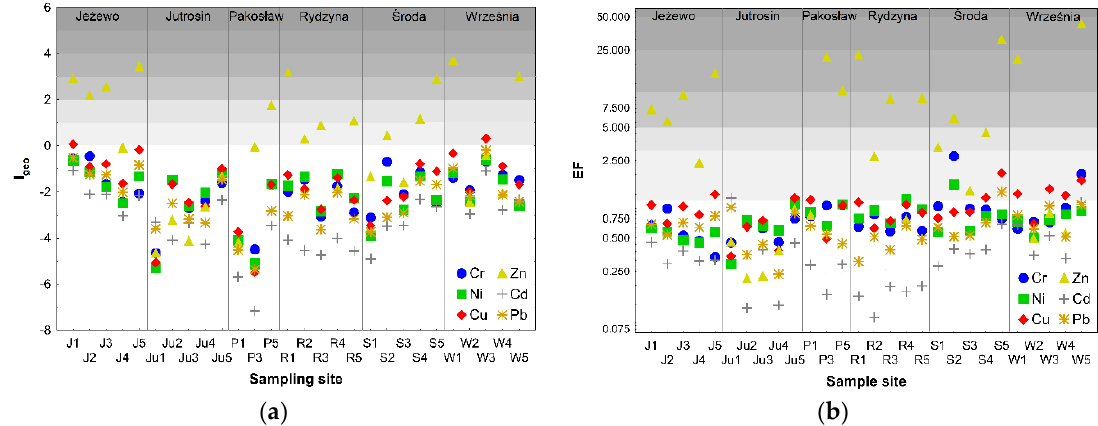
Figure 2. ( a ) Index of geo-accumulation I geo ; ( b ) enrichment factor (EF) values for HMs in bottom sediment sites.